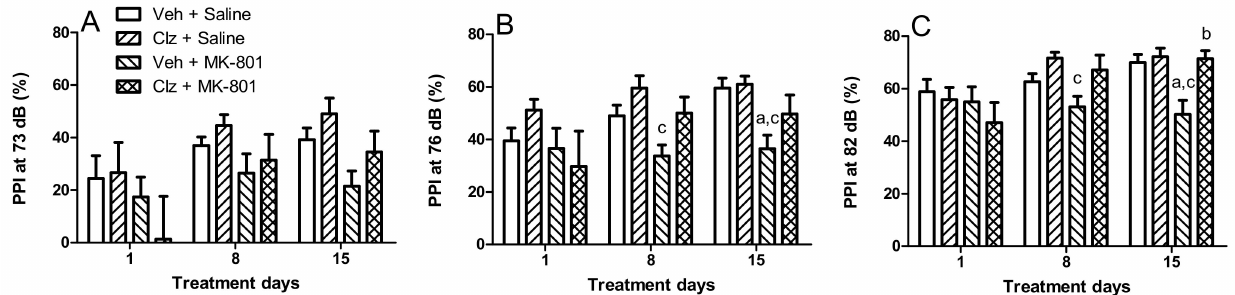
Figure 2. MK-801 induces pre-pulse inhibition deficits, which are ameliorated by clozapine treatment. Effects of clozapine 5 mg/kg (Clz), MK-801 0.1 mg/kg, and their combinations on prepulse inhibition (PPI) of rats on the 1st, 8th, and 15th days of the treatments at 73 ( A ), 76 ( B ), and 82 ( C ) decibel (dB) prepulse intensity levels ( a p < 0.05, compared to Veh + Saline group; b p < 0.05, compared to Veh + MK-801 group; c p < 0.05, compared to Clz + Saline group, post hoc Tukey’s tests; Veh, vehicle, n =